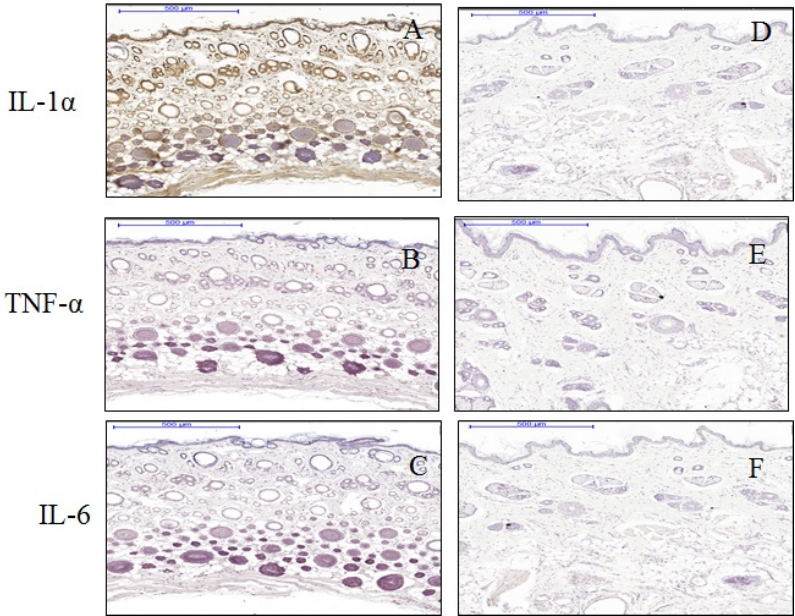
Figure 4. Immunohistochemical staining of IL-1 ( A , D ), TNF- α ( B , E ), and IL-6 ( C , F ) in expanded ( A – C ) and control ( D – F ) tissues. Expanded tissues ( A ) show strong cytoplasmic and nuclear positivity (brown color) of IL-1in the epidermis, dermis, and hypoderm compared to controls ( D ). Enhanced expression of IL-1 was detected in the nucleus of keratinocyte. Additionally, all the collagen fibers in the dermal layer were IL-1-positive compared to controls. However, expression of TNF- α and IL-6 did not show any differences between the expanded ( B , C ) and control tissues ( E , F ). Materials 2020 , 13 , x FOR PEER REVIEW